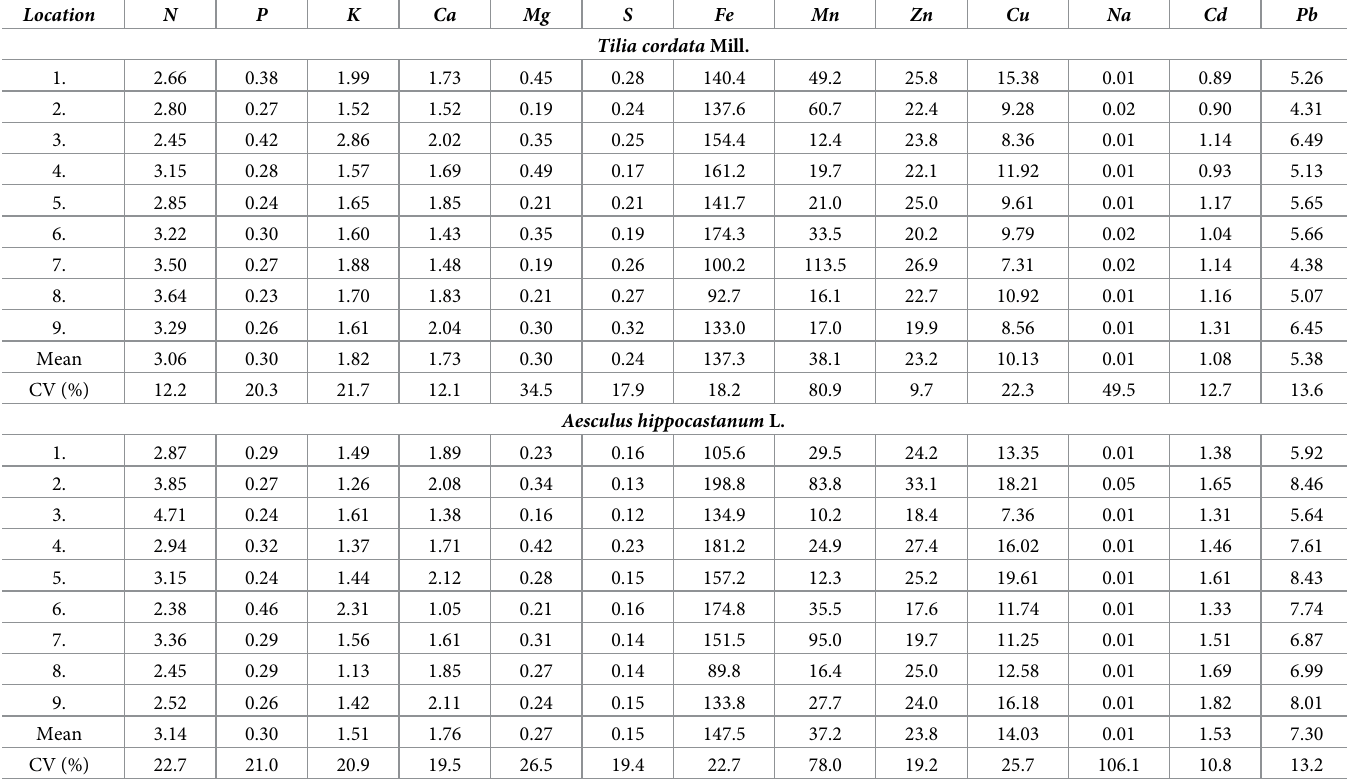
Table 5. Chemical composition of leaves and coefficients of their